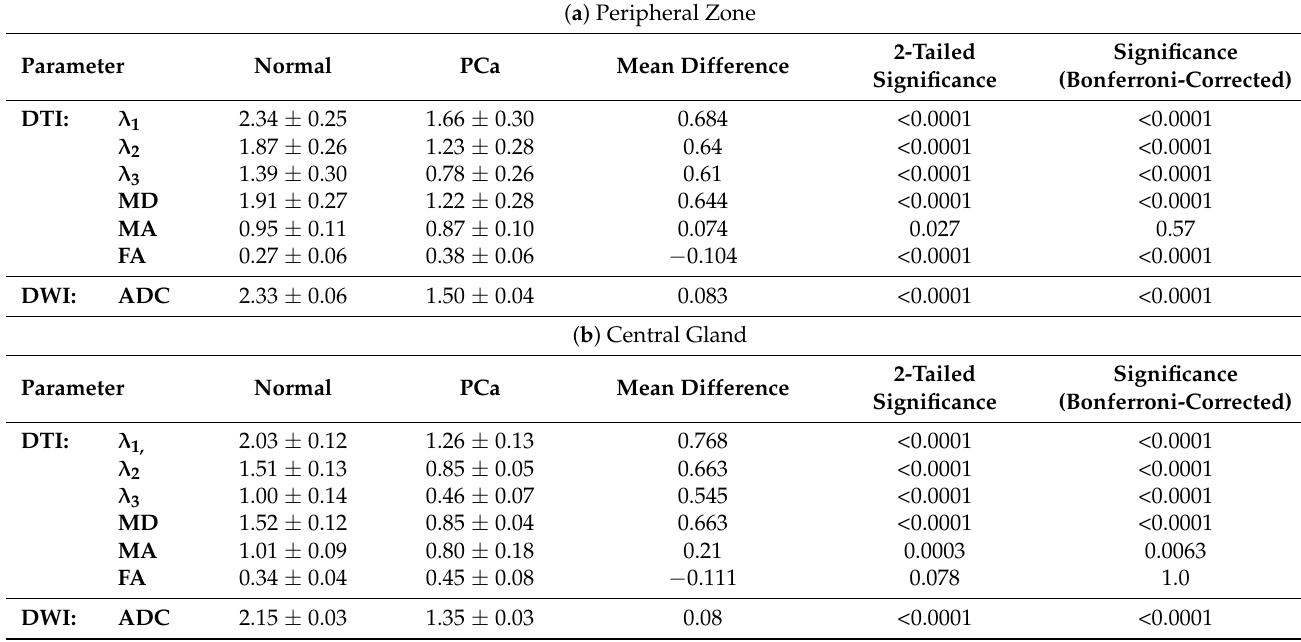
Values are presented as mean ± standard deviation. Significance is corrected for multiple comparisons according to Bonferroni, across Tables 2 and 3a,b. λ 1to3 , MD, MA, and ADC values presented in × 10 − 3 mm 2 /s. ADC: apparent diffusion coefficient; DTI: diffusion tensor imaging; DWI: diffusion weighted imaging; FA: fractional anisotropy; MA: maximal anisotropy; MD: mean diffusivity; PCa: prostate